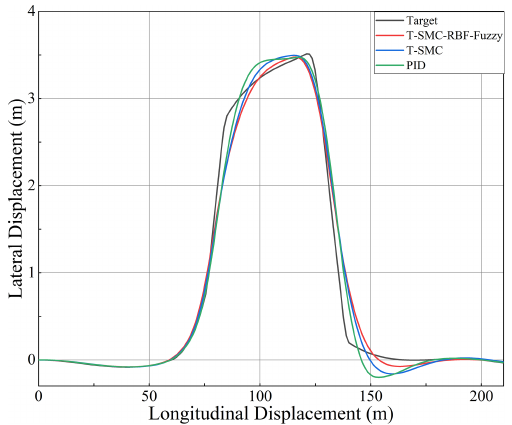
Figure 19. Steering angle of different controllers.